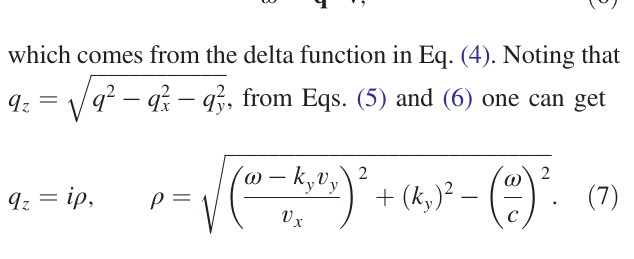
FIG. 2. (a) Conical diffraction at the reflection of monochro- matic light from a grating. Separated lines on the conical surface refer to different diffraction orders m . (b) Conical diffraction: reducing the cone to a plane in case of k 0 y ¼ 0 (for light reflection) or α ¼ 0 (for radiation). The angle between velocity v and axis x is α